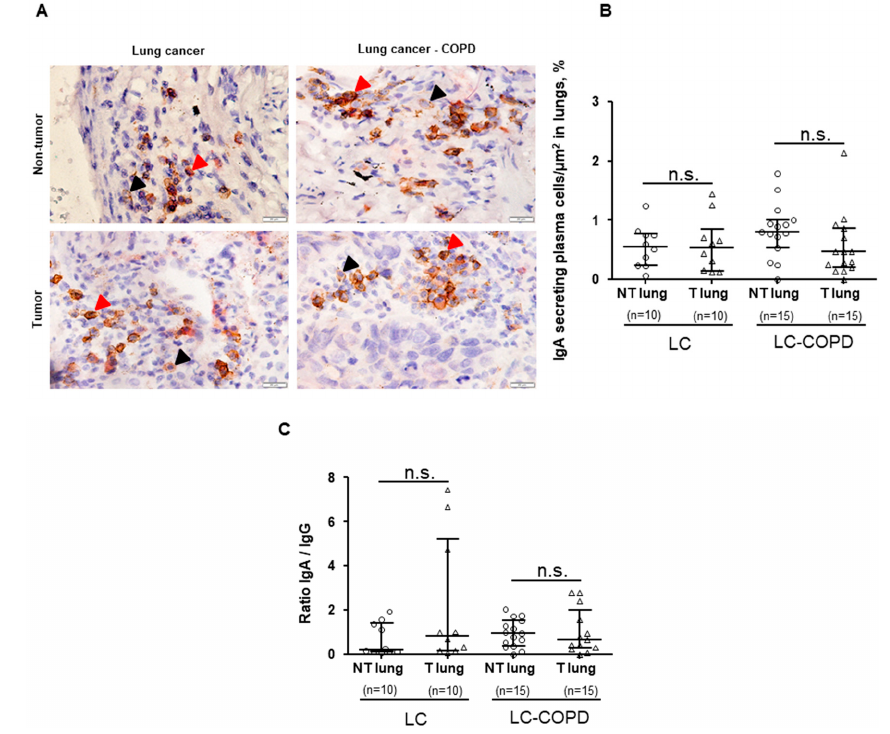
Figure 4. ( A ) Representative examples of double immunohistochemical staining for IgA-secreting plasma cells (CD138-IgA positively stained plasma cells) in LC and LC–COPD patients, respectively. All types of plasma cells (CD138+) are stained only in brown (black arrow), while IgA-secreting plasma cells (CD138+IgA+) are specifically stained with both brown and red. ( B ) Median and interquartile ranges between 75th and 25th percentiles of number of IgG-secreting plasma cells in the total measured area. Black-stained regions within the lungs correspond to anthracosis. ( C ) Median and interquartile ranges between 75th and 25th percentiles of IgA/IgG ratio in LC and LC– COPD patients, respectively. Comparisons were made between the non-tumor (NT) and tumor (T) samples and the LC and LC–COPD groups. For technical reasons, the number of patients in each group or type of samples (tumor and non-tumor) may differ. Statistical significance: n.s. No significance between tumor and non-tumor lungs in either LC or LC–COPD patients. Definition of abbreviations: LC, lung cancer; COPD, chronic obstructive pulmonary disease; CD, cluster of differentiation; Ig, immunoglobulin. 3.4. Cytokines Levels in Lung Specimens 3.4.1. Differences between LC–COPD and LC in either Tumor Lesions or Non-Tumor Specimens Protein levels of IL-10 and interferon-gamma cytokines did not significantly differ between LC– COPD and LC in either tumor or non-tumor lung specimens (Figure 5A,B). 3.4.2. Differences between Tumor and Non-Tumor Parenchyma in LC–COPD and LC Patients. Levels of IL-10 significantly increased in the tumors compared to non-tumor specimens only in LC–COPD patients, whereas no significant differences were found in interferon-gamma levels between tumor and non-tumor lung specimens in either LC or LC–COPD patients (Figure 5A,B). A